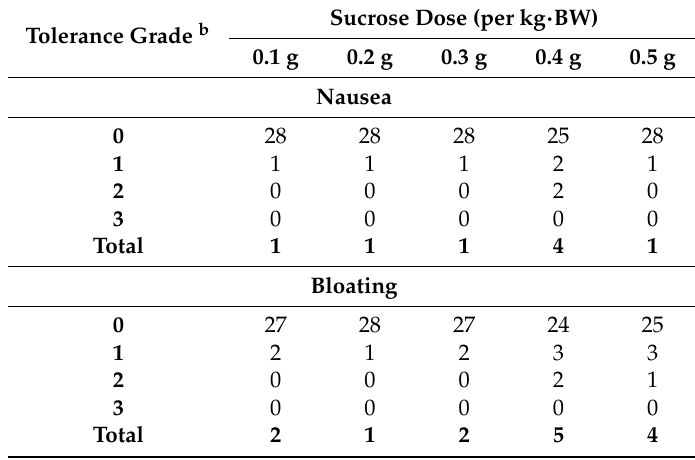
Table 7. GI symptoms in the 24 h following the consumption of the test drinks containing sucrose, for occasional ingestion (number of subjects reporting symptoms, n = 29 a